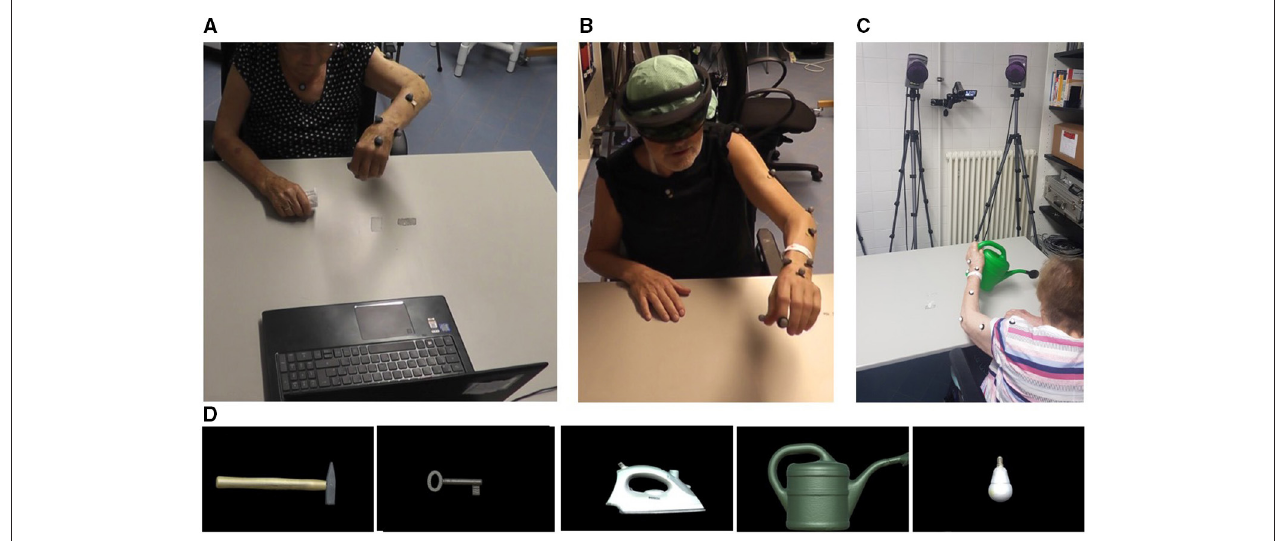
FIGURE 2 | Third person perspective of the experimental setup. (A) Screen condition, (B) HMD condition, (C) Real Tool condition; and (D) the first-person perspective of the five objects depicted as screen-based images. Only the tools and not the target items were shown (i.e., the hammer, but not a